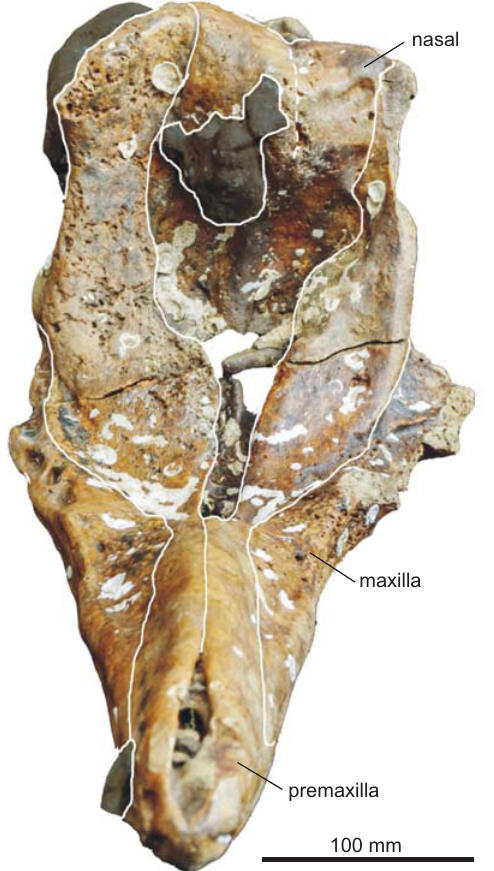
Fig. 3. Partial cranium of a beaked whale Beneziphius cetariensis sp. nov., holotype (SGHNMF MA0953) from the middle Miocene to early Pliocene of A Selva fishing ground, off the Galician coast, Spain, in anterior and slightly dorsal